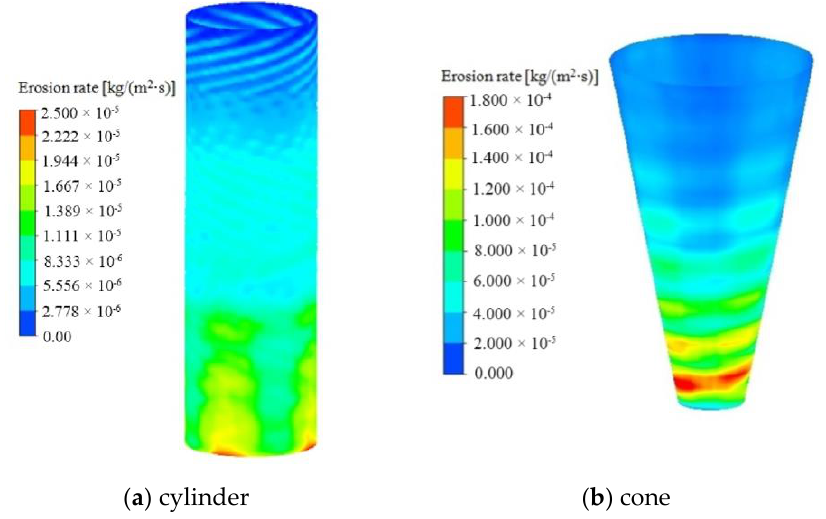
Figure 8. Erosion location of the cylinder and cone.